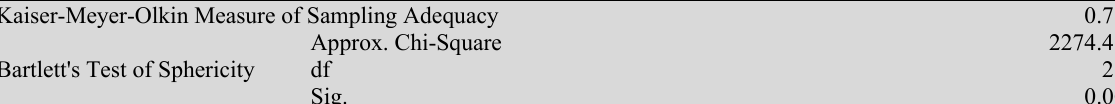
KMO and Bartlett's Test